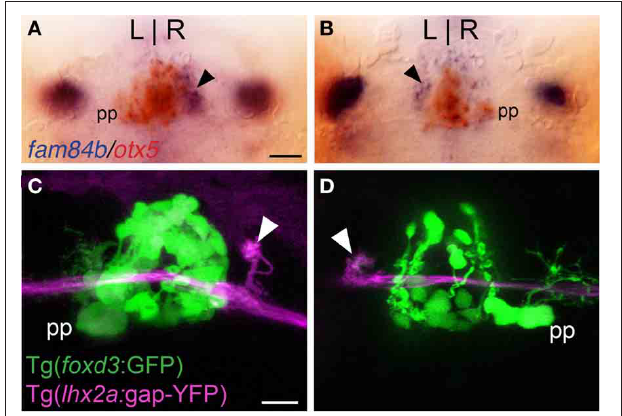
FIGURE 2 | Asymmetric olfactory input is contralateral to the parapineal. (A,B) Larvae with the parapineal (pp) on the left of the pineal anlage exhibit fam84b expression (blue) in the right dorsal habenula (black arrow). Conversely, spontaneous L-R reversal of parapineal position corresponds with fam84b expression on the left. The pineal complex expresses the otx5 gene (red), revealed by double label in situ hybridization methods. (C,D) Live imaging of Tg ( foxd3 : GFP ) fkg17 ; Tg ( -10lhx2a:GAP-EYFP ) zf177 larvae. When the parapineal is on the left, lhx2a:YFP labeled terminals (white arrowhead) are found in the right dorsal habenula. With L-R reversal of epithalamic asymmetry, olfactory axons terminate in the left dorsal habenula. All larvae 4 dpf. Scale bars = 50 μ m for (A,B) and 25 μ m for (C,D)